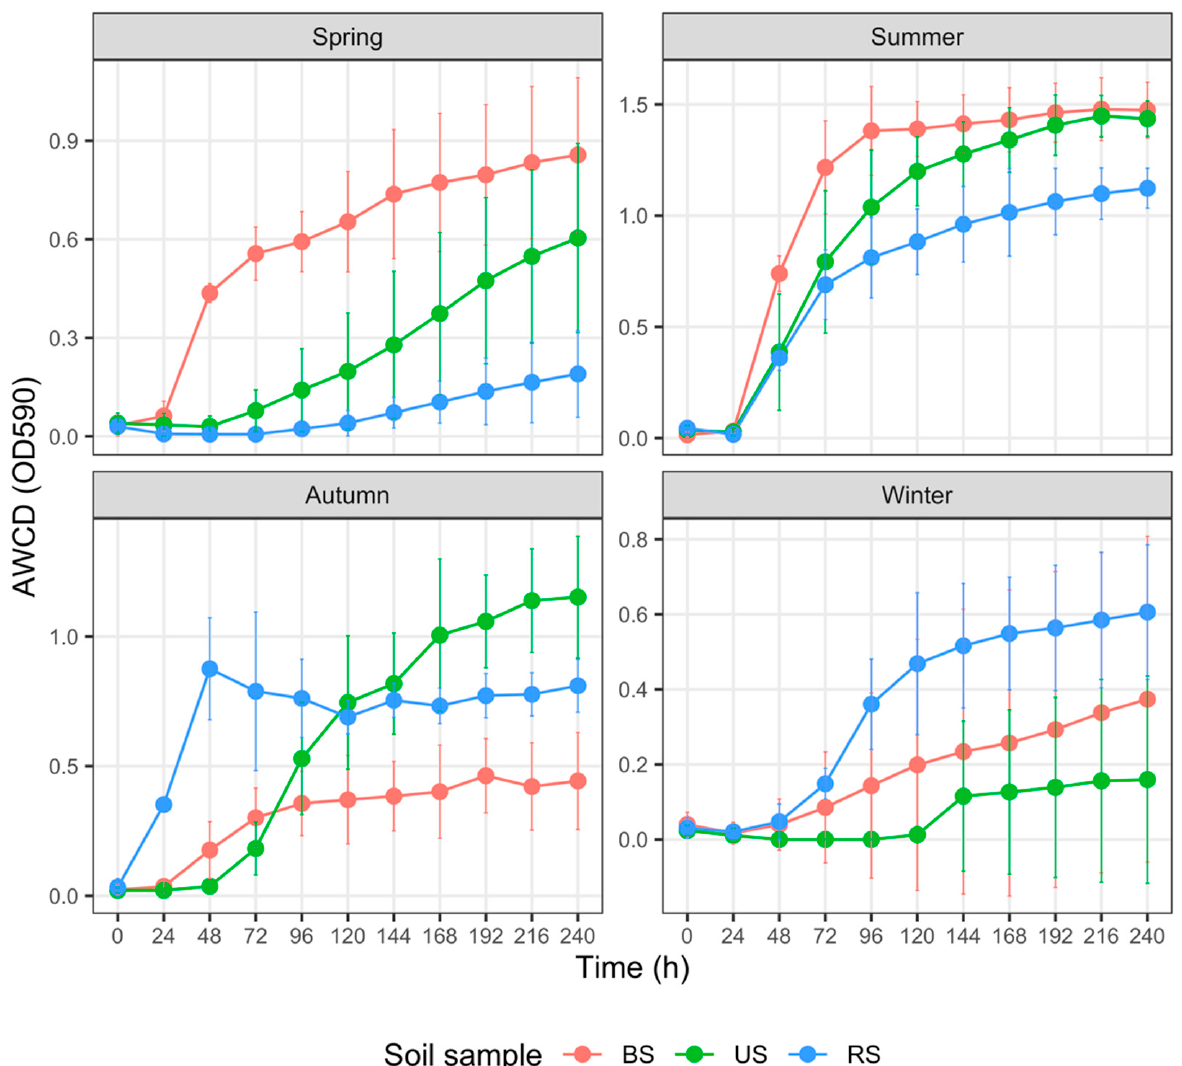
Figure 6. Variation in the average well color development (AWCD) of carboxylic and acetic acids among three groups of soil samples collected in different seasons. The error bar represents the mean ± SD ( n = 3). AWCD values at the 240th h for each soil sample were compared via the Kruskal–Wallis